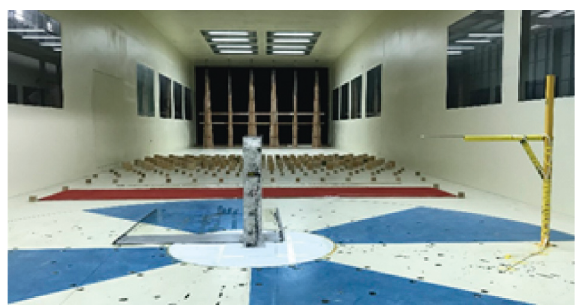
Figure 12: Wind tunnel test model.